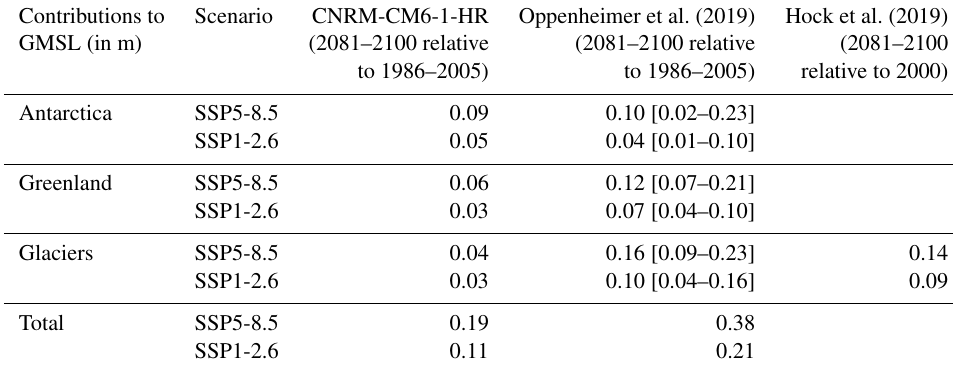
Table 2. Projected global mean changes in SL mass dominating contributions for the SSP5-8.5 and SSP1-2.6 scenarios in CNRM-CM6-1-HR (Oppenheimer et al., 2019; Hock et al.,